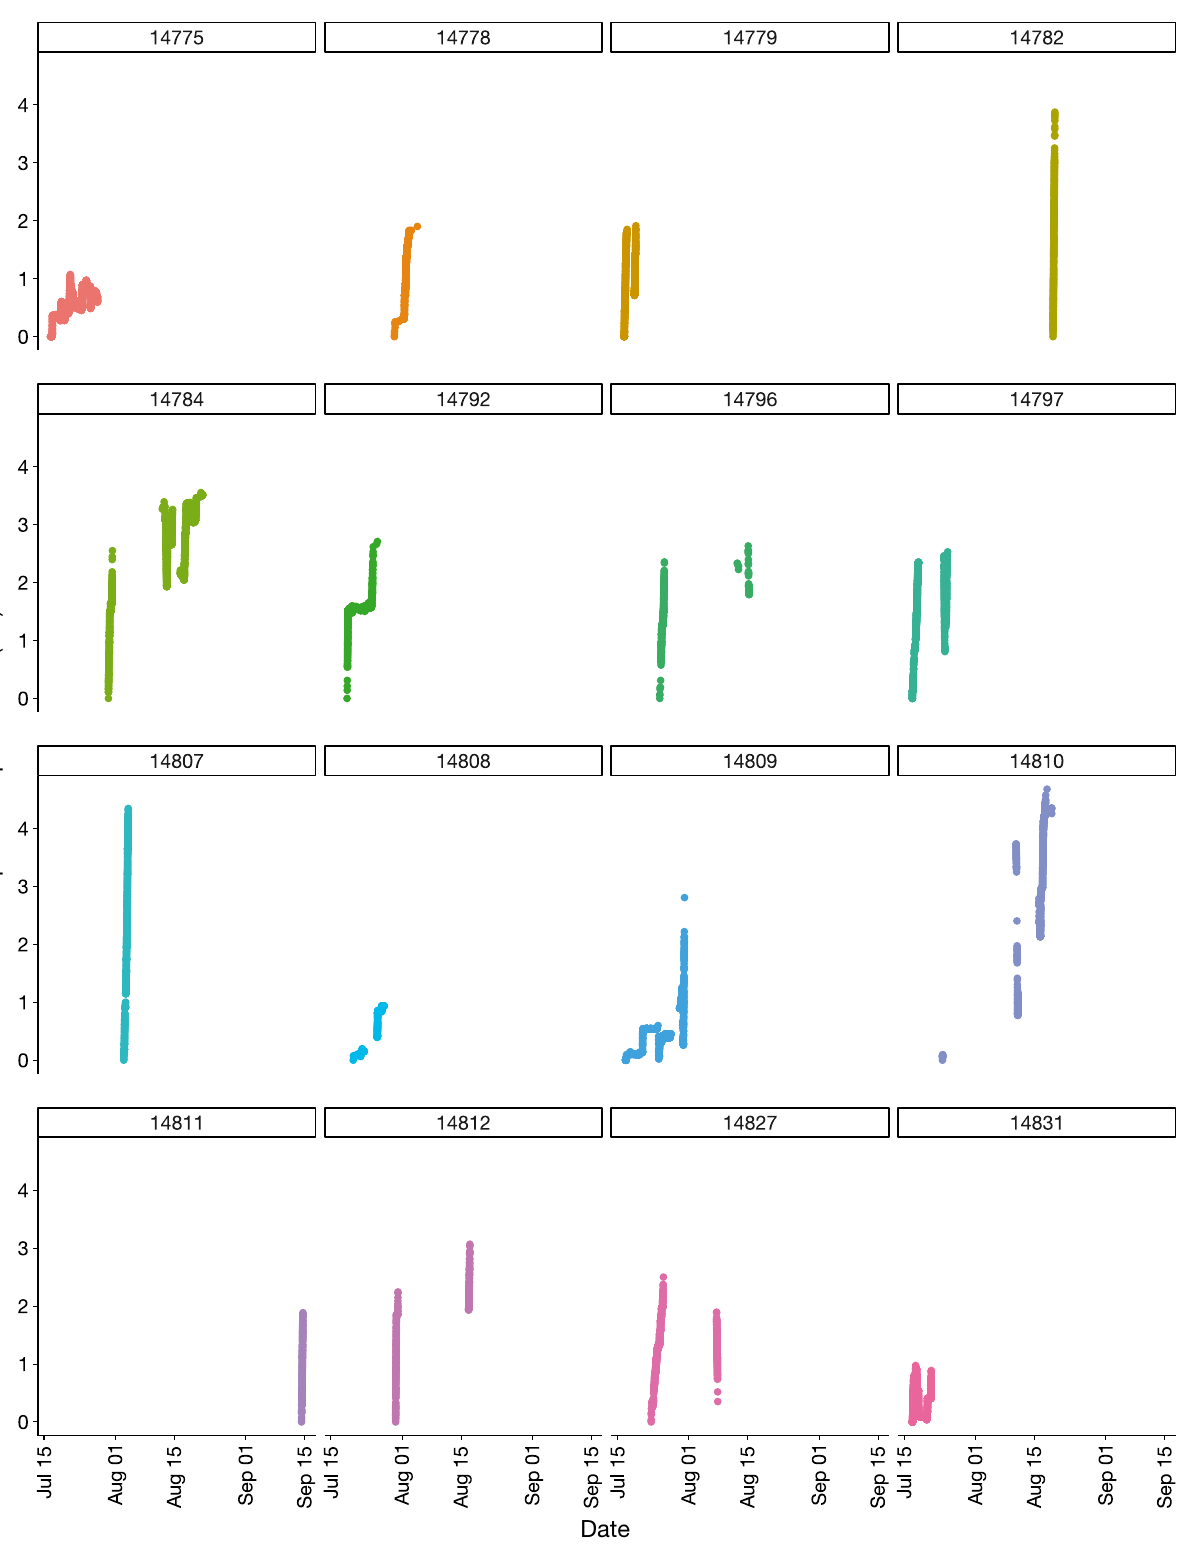
Fig. 5. Net squared displacement for each lobster that stayed or returned to acoustic arrays during post-acclimation in 2014 (n = 16). Numbers above each panel are individual lobster